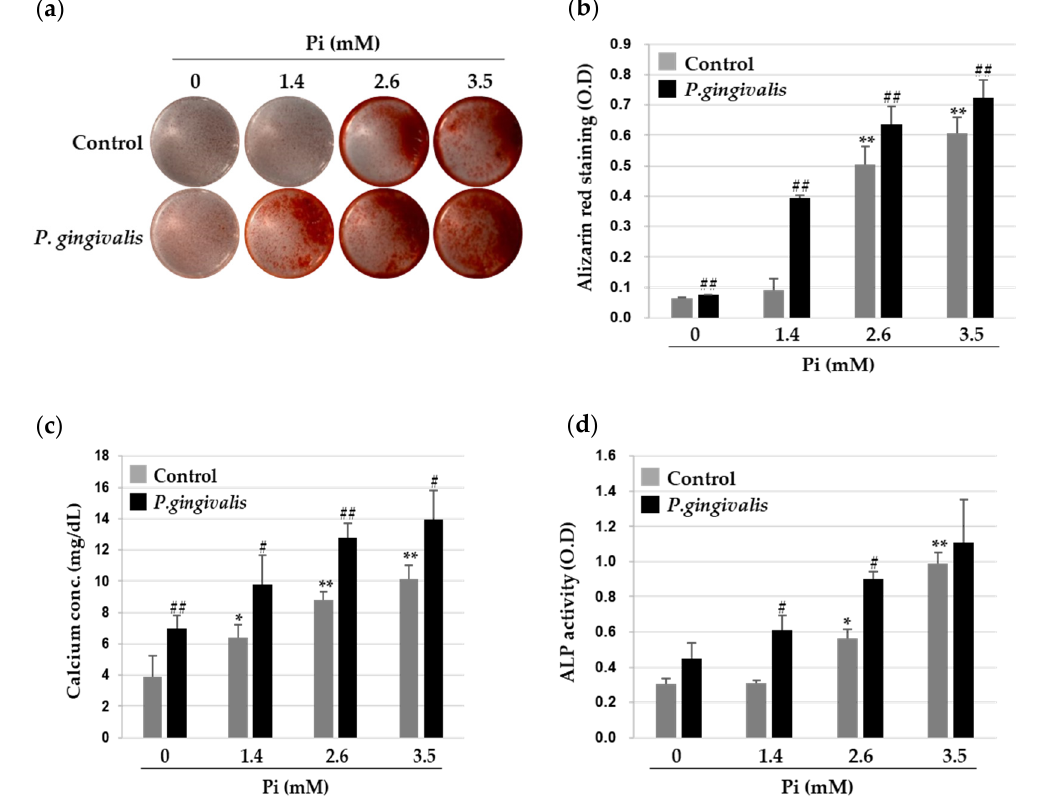
Figure 1. Effect of P. gingivalis in inorganic phosphate (Pi)-induced calcium deposition in vascular smooth muscle cells (VSMCs). A7r5 cells were infected with P. gingivalis for 3 h and cultured for five days in calcification medium containing 0, 1.4, 2.6, and 3.5 mM Pi. ( a , b ) Calcium deposition was stained with Alizarin Red S (left), and absorbance was measured to evaluate the degree of mineralization (right). ( c ) Calcium content was measured by a colorimetric calcium assay. ( d ) Alkaline phosphatase activity was measured and normalized to protein content for quantitative analysis. * p < 0.05; ** p < 0.01 vs. 0 mM Pi, # p < 0.05; ## p < 0.01 vs. control, one-way ANOVA followed by a Student’s t-test. Data shown are the mean ± SD, obtained for at least three independent experiments.